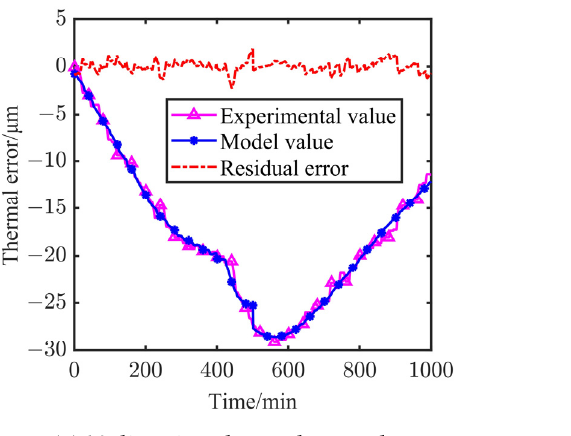
Figure 6. Temperature data of the selected key points for the second machine tool.